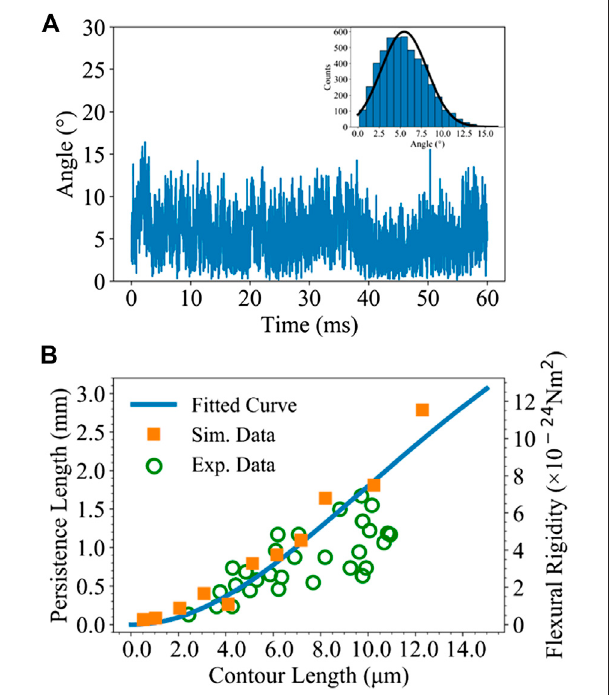
FIGURE7|(A) Theangle fl uctuationofa2 μ mmicrotubulemodelwithin 60 ms. The inset displays the histogram distribution of angles with a black fi tted Gaussian curve. (B) The orange solid squares show the relationship of the simulated persistence length and fl exural rigidity with respect to the contour length, fi tted with a blue curve based on Eq. 4 . The green hollow circlesdenotetheexperimentalmeasuredresults(Pampalonietal.,2006).The simulation time ranges from microseconds to milliseconds for the different